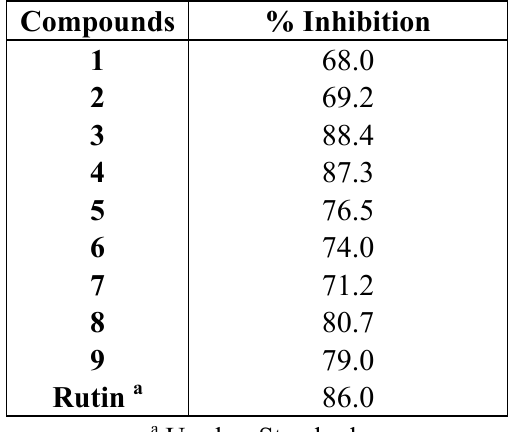
Table 2. Anti-glycation activity of compounds 1–9